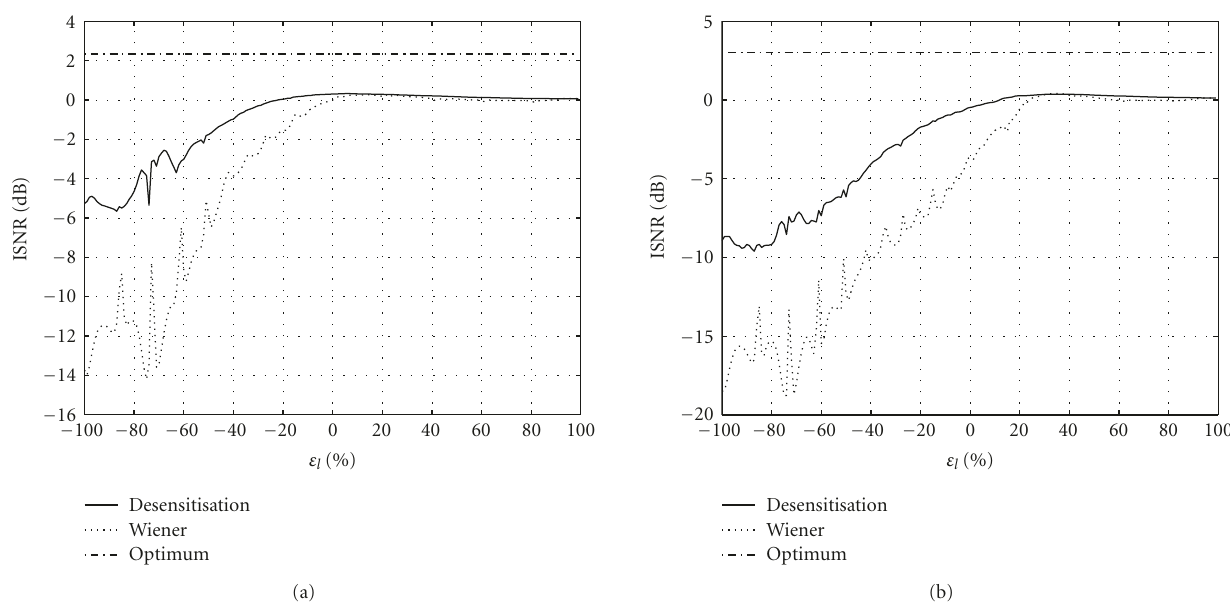
Figure 11: Distributions of ISNR obtained by both the Wiener filter and our desensitised method when a motion blur is estimated according to an inclination of 45 degrees and a number of 15 pixels altered by ε l while a Gaussian low-pass filter (a) and a uniform blur (b) are applied on the original image. Regarding noise, a Gaussian artefact is considered in relation to a BSNR of 20 dB. Besides, a horizontal line is included symbolizing the constant value of ISNR reached when optimum estimates are considered in the Wiener filter.